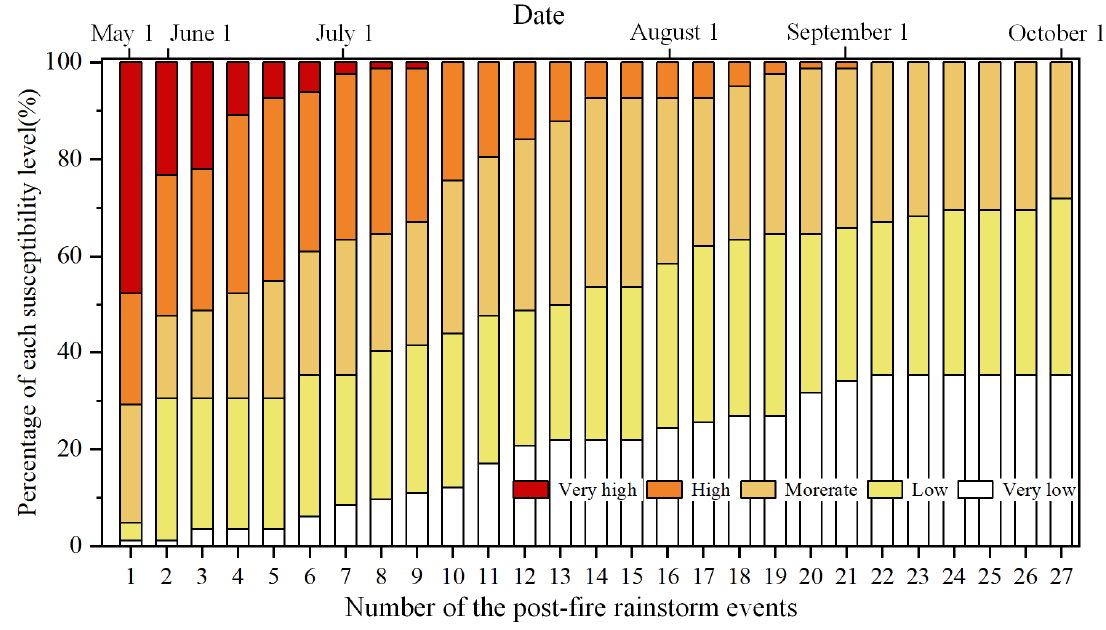
Figure 15. Evolution law of percentage of each PFDF susceptibility level in 82 watersheds in the study area over time (number of the post-fire rainstorm events).